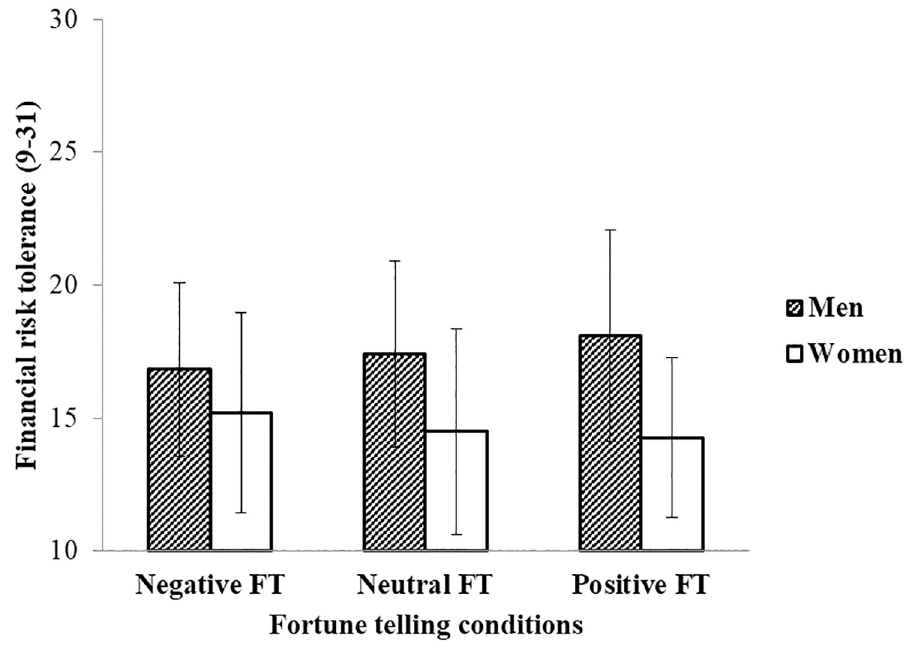
Fig 2. Mean financial risk tolerance among fortune-telling conditions for men and women. Error bars represent standard deviations in Study 2. https://doi.org/10.1371/journal.pone.0273233.g002 Table in S1 File); for women: b = − 1.14, SE = 0.61, t = − 1.87, p = .063, 95% confidence interval (CI) = [ − 2.34, 0.06] (See S4 Table in S1 File). Risk taking across domains. As can be seen in Table 3, people’s beliefs in fortune telling was an important predictor for people’s risk-taking behaviors across all the domains. Except for the social domain, the stronger people believed in fortune telling, the more likely they took risks. In addition, gender was an important factor determining people’s risk-taking behaviors. Compared to women, men were more risk-taking across all the domains except in the social domain. Moreover, we found that independent of gender, the fortune telling manipulation had a significant effect on people’s risk taking in the ethical ( F (2, 434) = 3.36, p = .036; η .015), and health and safety domains ( F (2, 434) = 3.69, p = .026; η other domains. Unexpectedly, as can be seen in Table 3, the more negative fortune telling Table 3. ANCOVA for influence of fortune telling manipulation on risk taking in different domains in Study 2.